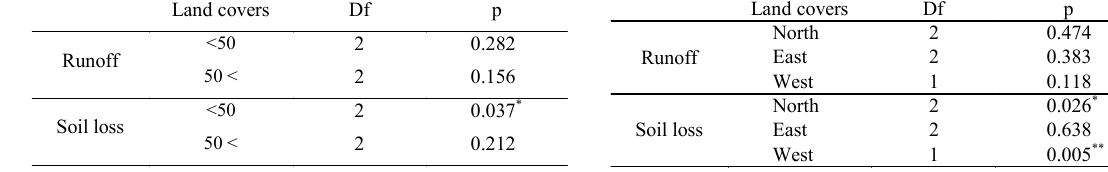
Table 7: The results of Kruskal-Wallis test on land cover sand runoff and soil loss in each slope class Land covers